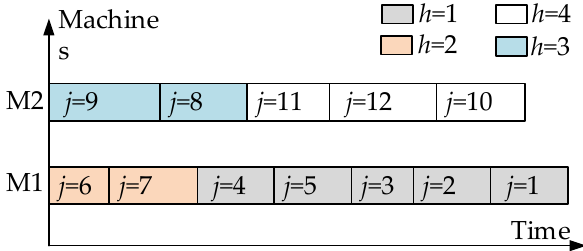
Figure 5. Gantt chart of scheduling plan.